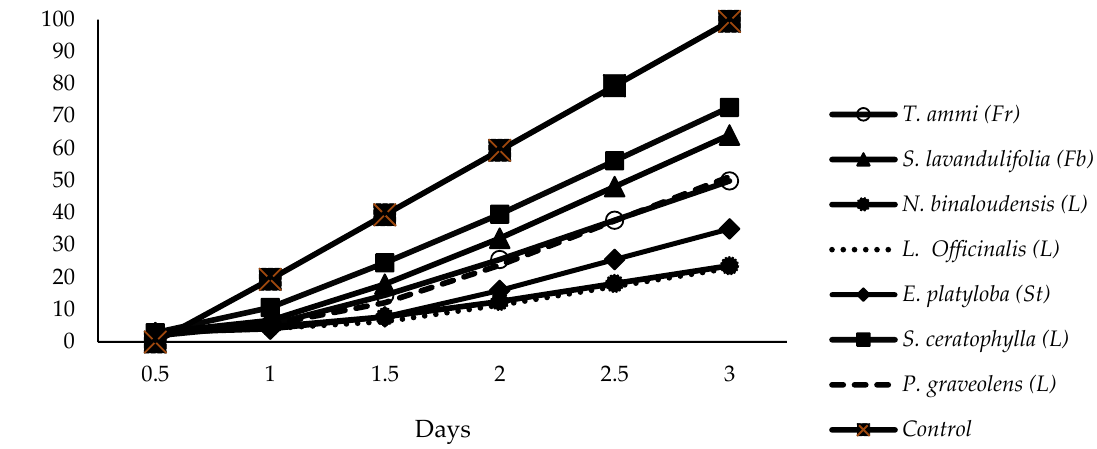
Figure 4. Effect of the strongest inhibitory plants on germination percentage of lettuce seeds.